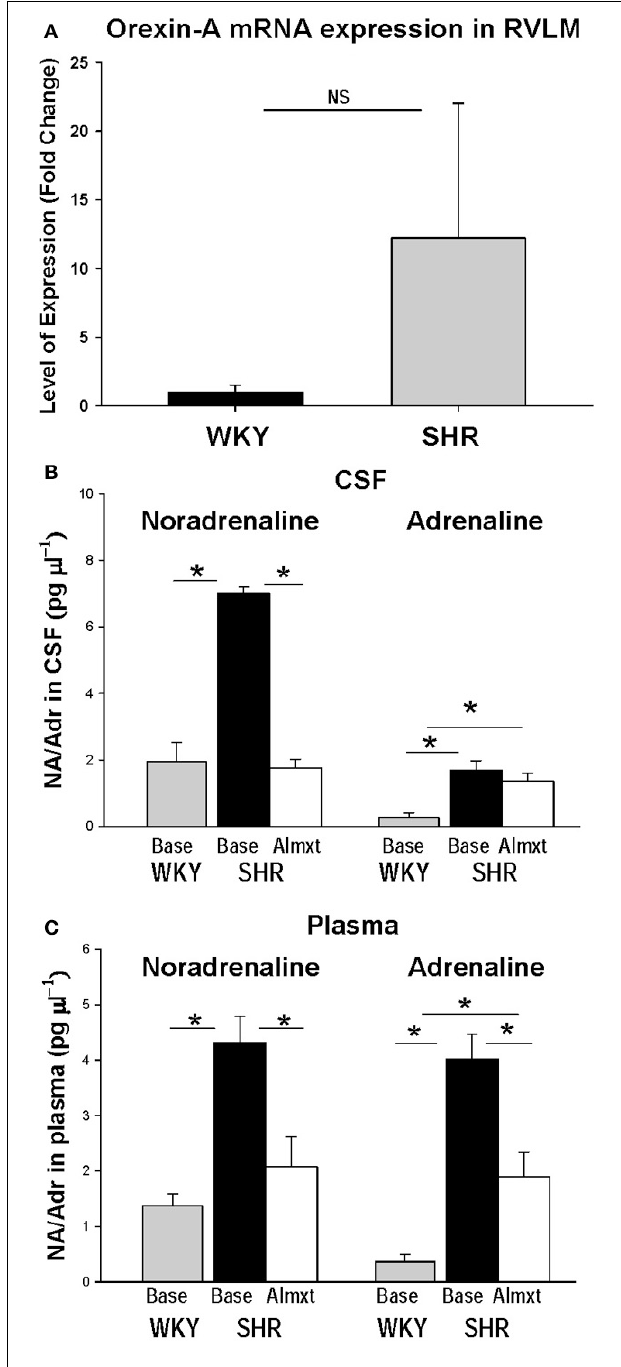
FIGURE 5 | In the RVLM of SHR, OX-A mRNA expression is increased as is noradrenaline in CSF and plasma. There is clear trend toward an increase OX-A mRNA expression in RVLM in SHR relative to normotensive WKY rats (A) . Antagonism OXRs with Almxt significantly decreased the elevated levels of noradrenaline (NA) in CSF (B) , and both NA and adrenaline (Adr) in plasma in SHRs (B,C) . (Figure adapted with permission from Li et al., 2013a). ∗ Significantly difference ( P < 0 . 002, One-Way ANOVA with Student–Newman–Keuls